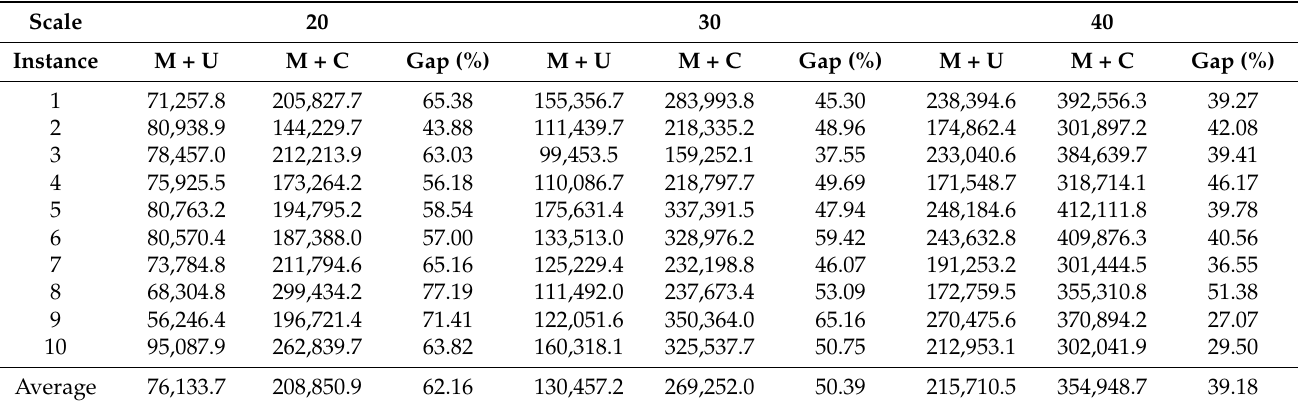
Table 7. The objective value of solutions under M + C and M +